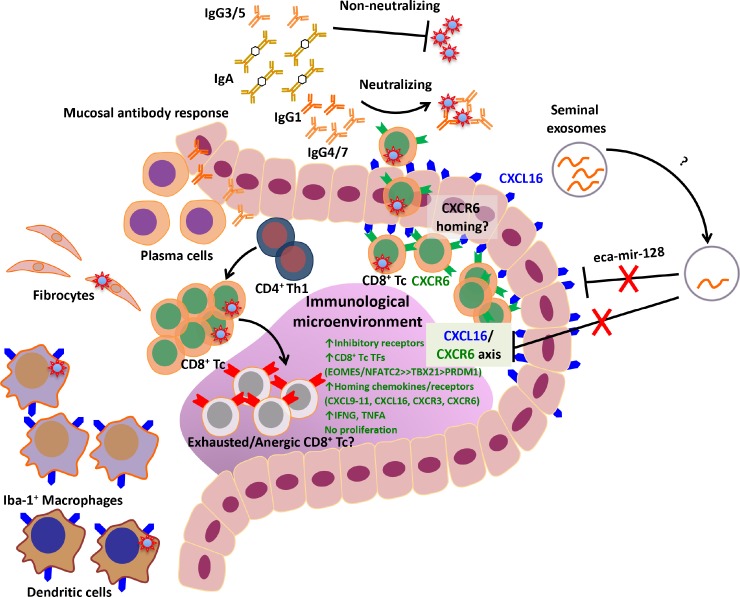
Schematic representation of the current knowledge of EAV persistence in the reproductive tract of the stallion.EAV tropism during persistent infection is associated with CD8+ T lymphocytes and CD21+ B lymphocytes infiltrating the ampullae, fibrocytes, tissue macrophages and dendritic cells. Long-term persistence is associated with a strong inflammatory response primarily mediated by CD8+ T lymphocytes and a smaller population of CD4+ T helper 1 lymphocytes. Additionally, local plasma cells produce diverse EAV-specific immunoglobulin isotypes with varying neutralizing abilities that are shed into the seminal plasma. Long-term persistence is associated with an enhanced expression of the chemokine CXCL16 in the mucosal epithelium and lymphocytes and with the downregulation of seminal exosome eca-mir-128, a putative modulator of the CXCL16/CXCR6 axis. Expression of the CXCL16 receptor, CXCR6, is also upregulated in lymphocytes, and along with other chemokines and receptors (CXCL9-11, CXCR3) likely mediates specific homing of infected lymphocytes into the reproductive tract of the stallion and migration of these cells across the epithelial lining, and drives an immunologically unique microenvironment that favors viral persistence. The inflammatory process is accompanied by upregulation of inhibitory receptors (PDCD1, CTLA-4, among others) and predominance of the transcription factors EOMES and NFATC2, potential mediators of CD8+ T lymphocyte hyporesponsiveness that leads to viral persistence. CD8+ Tc, CD8+ T lymphocytes; CD4+ Th1, CD4+ T-helper 1 lymphocytes; CD21+ Bc, CD21+ B lymphocytes.